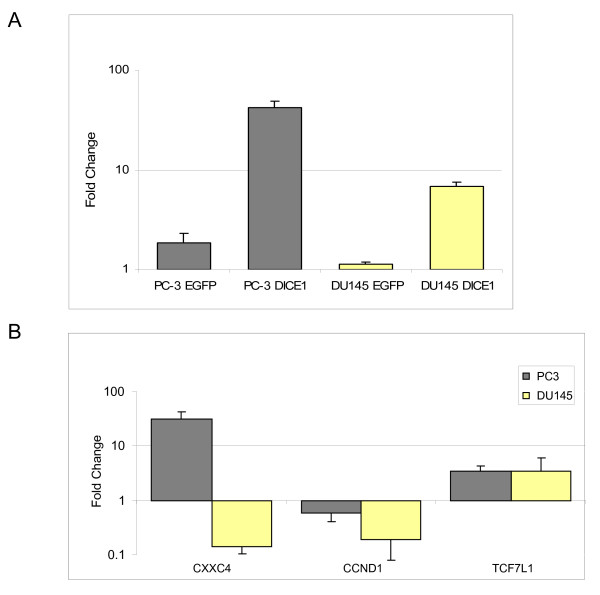
Real-time PCR of INTS6/DICE1 responsive genes. A. Up-regulation of INTS6/DICE1 expression in PC3 and DU145 cells 48 hours post-transfection with DICE1-EGFP fusion construct (DICE1) or EGFP vector (EGFP) as control. B. Selected INTS6/DICE1 responsive genes of the Wnt signaling pathway, CXX finger 4 (CXXC4), cyclin D1 (CCND1) and transcription factor 7-like 1 (TCFL1) monitored 48 hours after exogenous DICE1 expression in PC3 and DU145 cells. The fold change in gene expression was determined by the comparative C(T) method using G3PDH as reference.